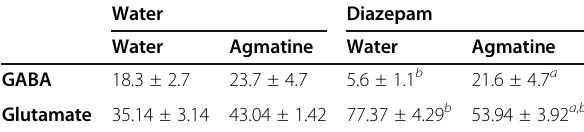
Table 2 Effects of agmatine administration on brain GABA